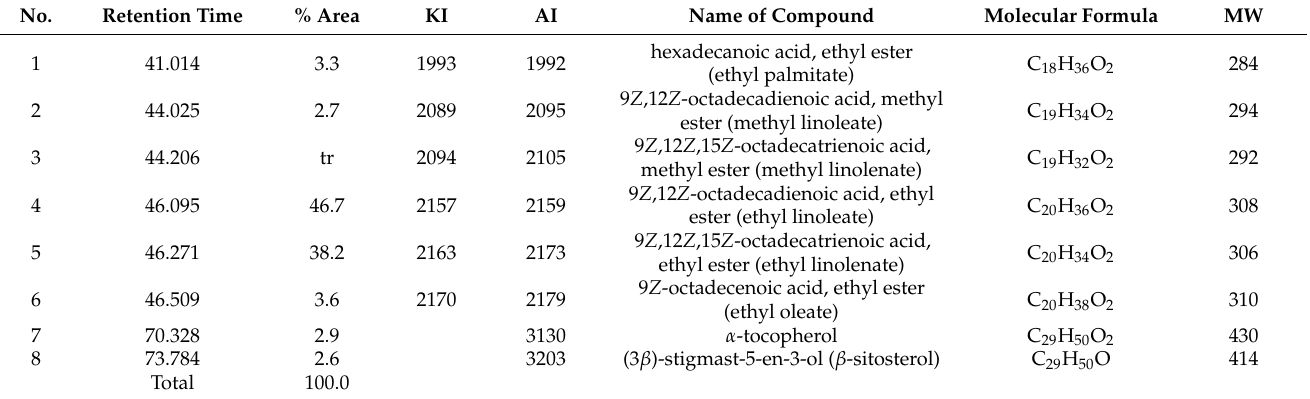
Table 2. Chemical composition of dichloromethane extract of Dioscorea communis berry juice (A1B).